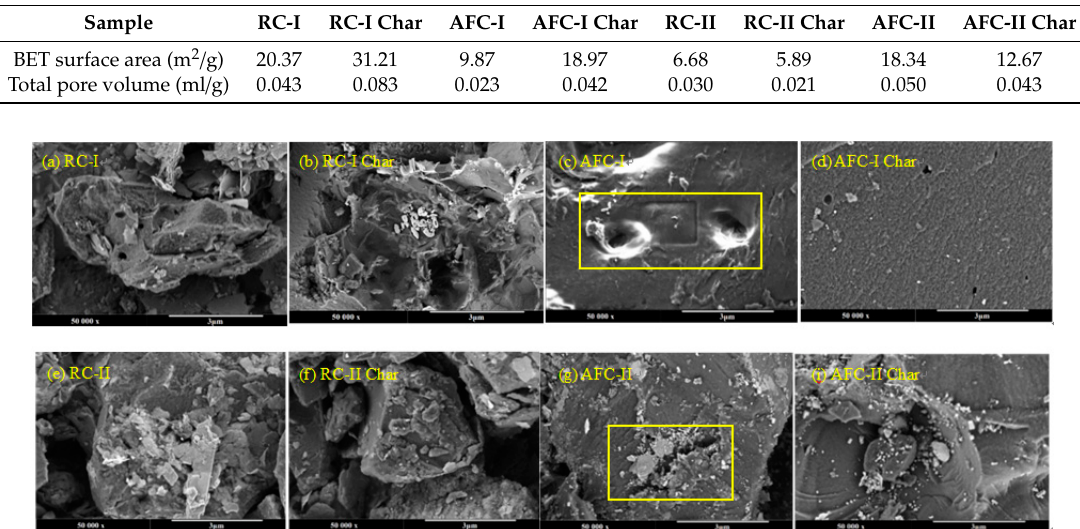
Figure 2. The reactivity index for raw coals (RCs), ash-free coals (AFCs).